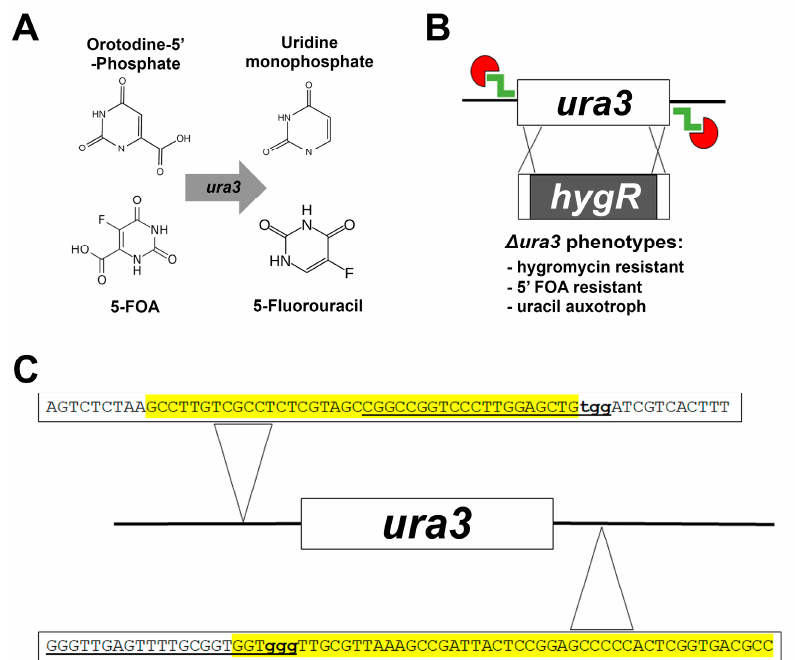
Figure 1. An overview of the ura3 deletion strategy using in vitro assembled Cas9 RNPs coupled with microhomology-mediated end joining (MMEJ). ( A ) Ura3 decarboxylates orotodine-5 ′ - monophosphate to form uridine monophosphate, an essential uracil precursor, as well as 5-fluorotic acid (FOA), added exogenously, to form a toxic metabolite 5-fluorouracil. ( B ) Cas9 ribonucleoprotein (RNP)’s target the up and downstream regions of the ura3 gene and the MMEJ repair replaces ura3 with hygR resulting in uracil auxotrophy, 5-FOA resistance, and hygromycin resistance. ( C ) The regions of microhomology for the repair template are highlighted in yellow, the crRNA sequences are underlined, and the protospacer-adjacent motif (PAM) sites are bolded in lowercase.